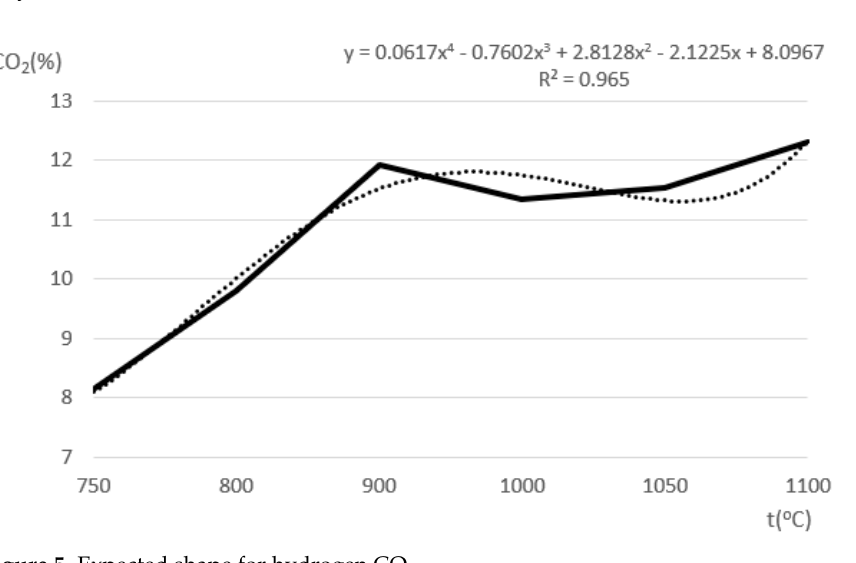
Figure 5. Expected shape for hydrogen CO 2 .